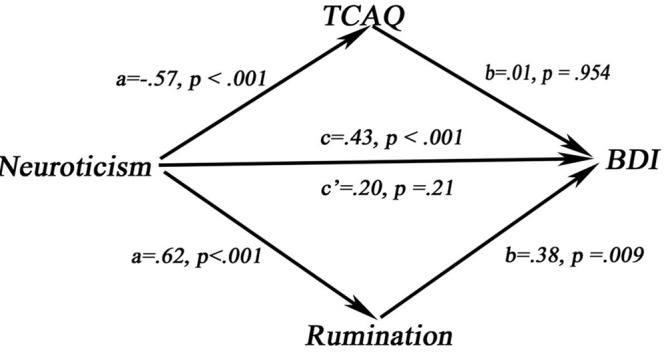
The mediating model.